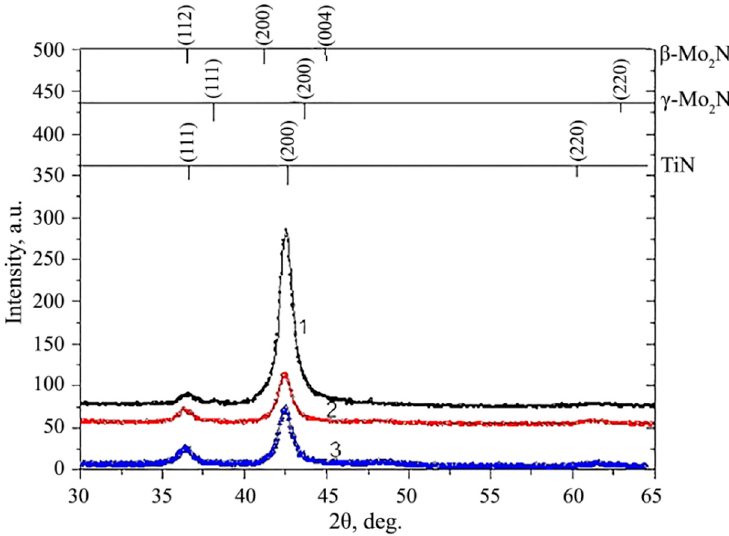
Figure 16. XRD pattern of the TiN/MoN coatings with different modulation period deposited at U b = − 40 V: (1) 25 nm; (2) 50 nm; (3) 100 nm. Reprinted with permission from [101] 2015 Elsevier.